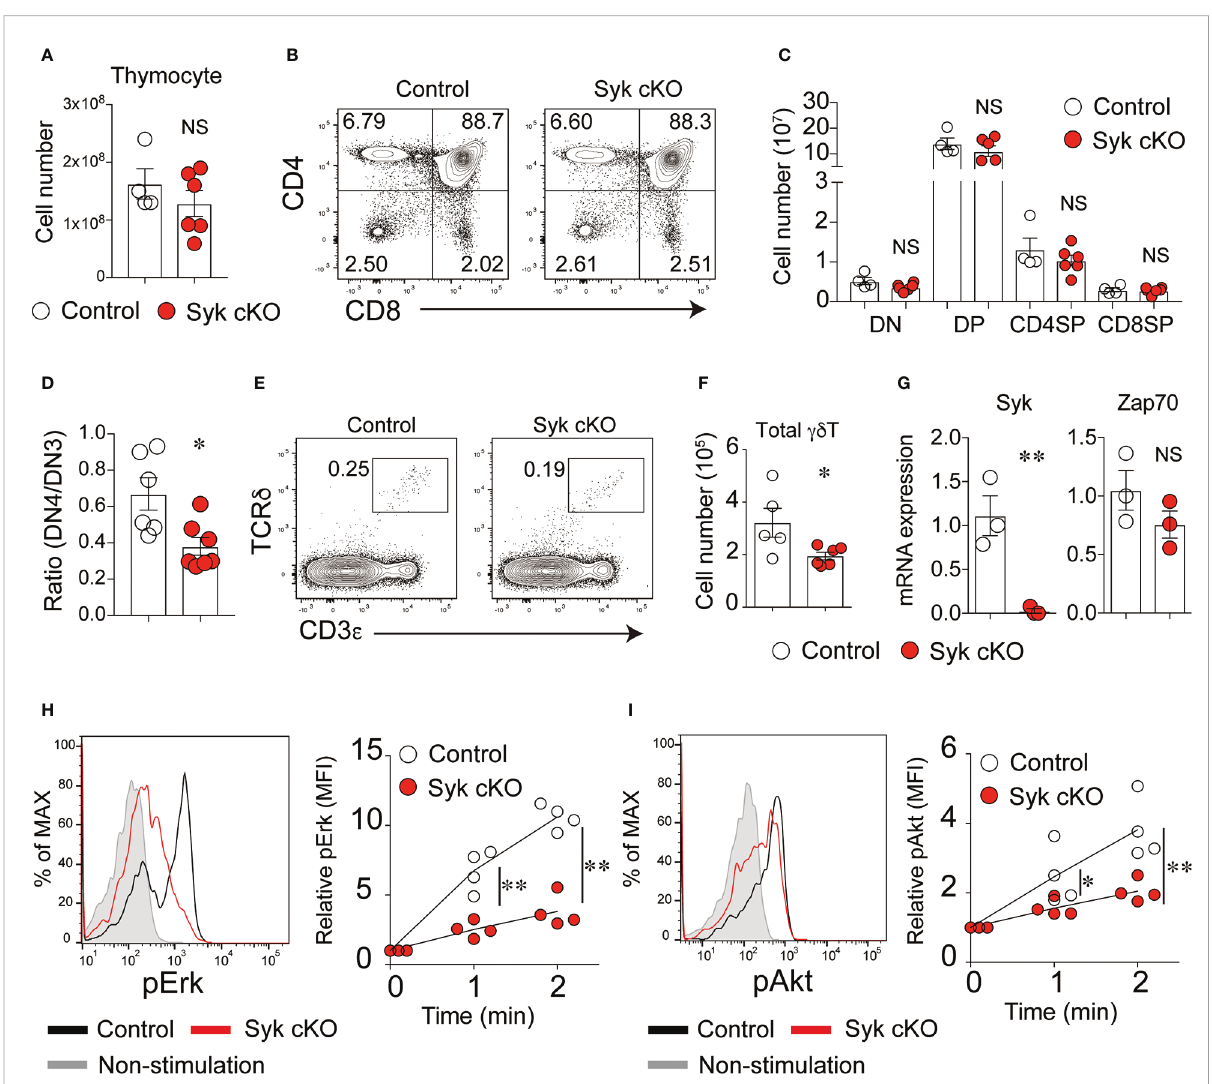
FIGURE 1 Syk is required for the development of gd T cells but not of ab T cells. (A) The number of thymocytes from 5-week-old control mice (Cd127-cre Syk fl ox/wt) or Syk-cKO mice (Cd127-cre Syk fl ox/ fl ox). Each circle indicates an individual mouse. (B) Flow cytometric pro fi les for CD4 and CD8 a expression in the total thymocytes from the indicated mice. (C) The graph indicates the number of DN, DP, CD4SP and CD8SP cells. (D) The ratio of CD25 lo CD44 lo DN (DN4) to CD25 hi CD44 lo DN (DN3) cells is shown. (E) Flow cytometric pro fi les for CD3 e and TCR d expression in the total thymocytes from the indicated mice. (F) The number of thymic gd T cells is shown. (G) mRNA expression of Syk and Zap70 in sorted thymic gd T cells from control and Syk-cKO mice. Gene expression was normalized to Gapdh mRNA. (H, I) The phosphorylation of Erk (H) and Akt (I) induced by anti-CD3 e stimulation in thymic gd T cell. Representative fl ow cytometric pro fi les of the phospho-Erk (pErk) and phospho-Akt (pAkt) levels after 2-minutes of stimulation are shown. Graphs indicate the changes in the mean fl uorescence intensity (MFI) of pErk and pAkt in the stimulated cells relative to non-stimulated cells. All data represent the mean ± SEM of at least two independent experiments. *P < 0.05 and **P < 0.01, by unpaired t-test. NS, not signi fi